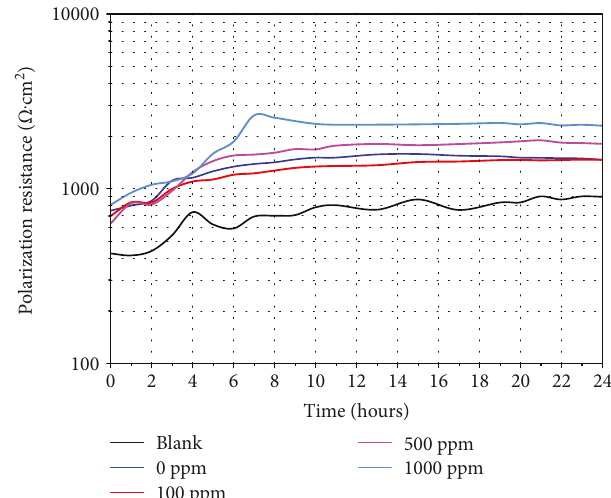
Figure 10: Variation in polarization resistance values for 1018 carbon steel bare and coated with chitosan doped with